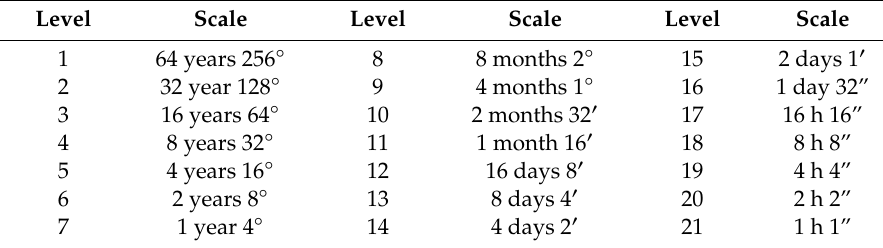
Table 2. GeoSOT spatiotemporal cube scales of di ff erent levels.